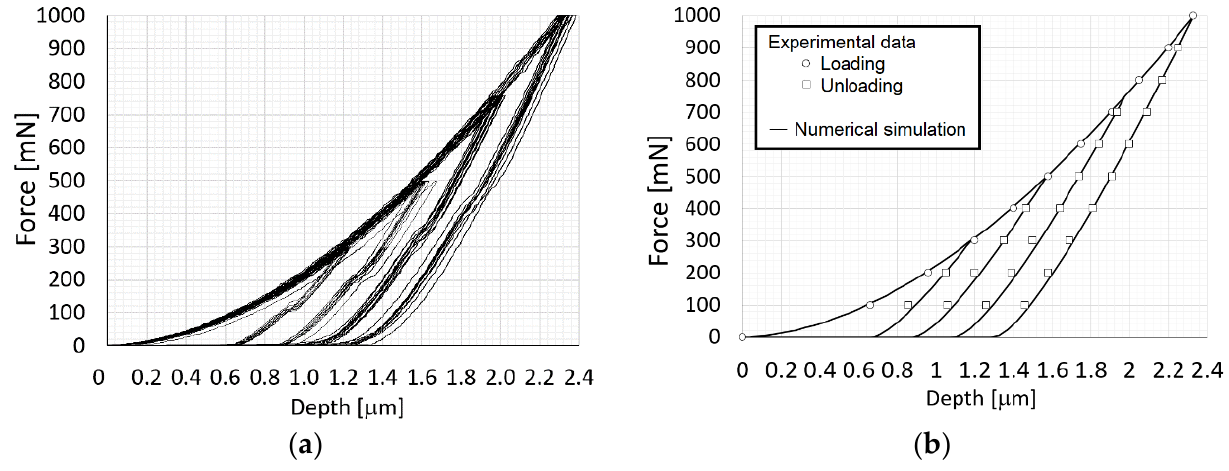
Figure 3. Representative force–depth curves from indentation tests: ( a ) experiment, ( b ) numerical simulation after calibration.